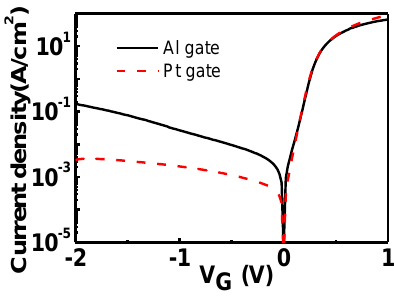
Figure 18. The dark currents of Al/SiO inversion current of the Pt gate device was smaller due to the suppression of electron tunneling from the metal to n-Ge [56].